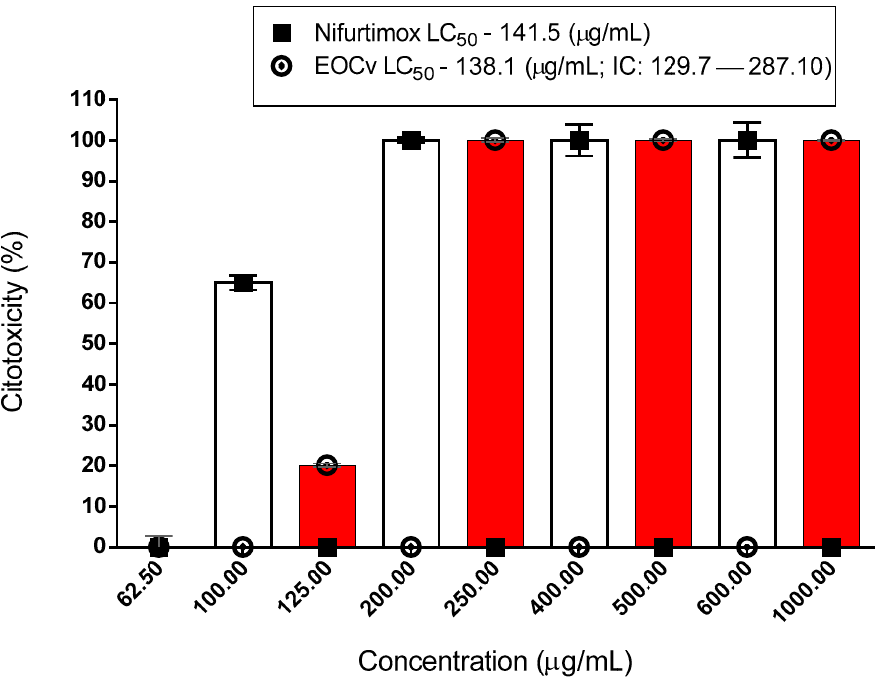
Figure 1. Cytotoxicity of C. verbenaceae essential oil. EOCv (essential oil of C. verbenaceae ).